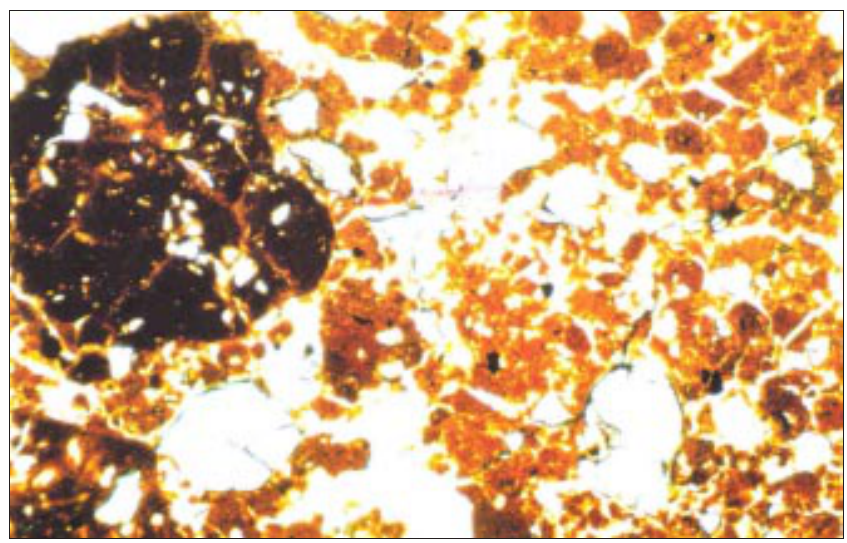
Figura 10. Fotomicrografia do horizonte A2 do Latossolo Húmico (P2). Em detalhe microagregado de origem biológica se